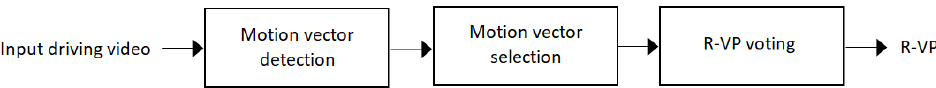
Figure 1. The main processing of existing motion-based road vanishing points (R-VP) detection methods.